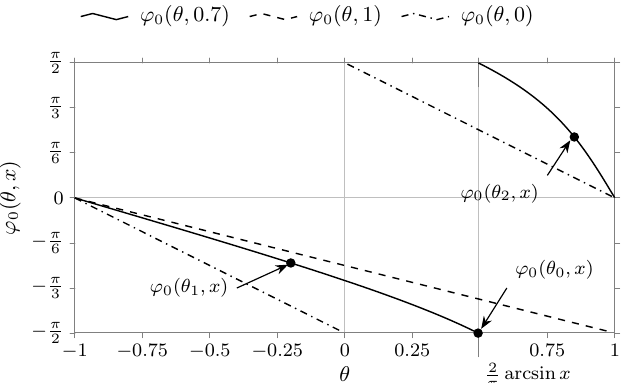
Figure 2. The graph of the function ϕ 0 ( θ , x ) at x (cid:54) 1. The figure shows the graphs for values x = 0,0.7,1. Heavy dots designate the values of this function with the value of the parameter θ = θ 0 , θ 1 , θ 2 and x = 0.7 corresponding to Figure